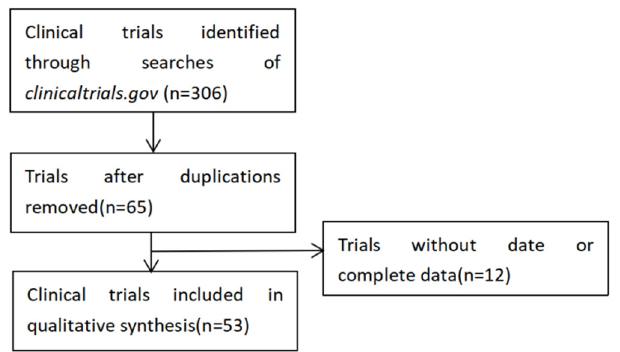
Figure 1. Flowchart of the selection process of the included studies.